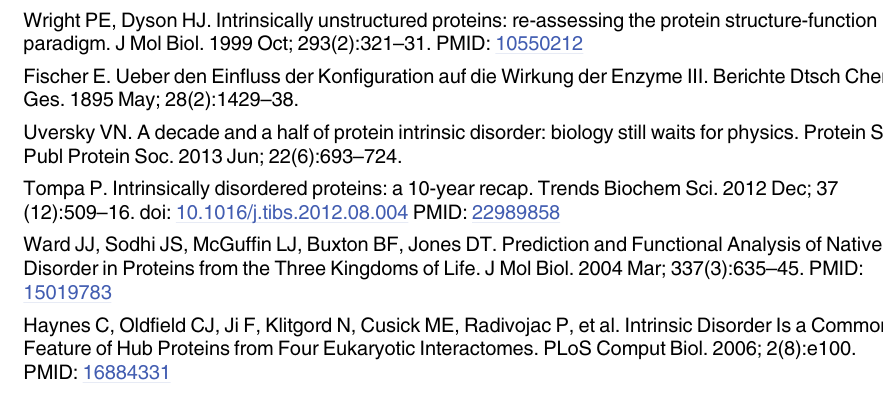
S1 Fig. IDRs are enriched in the cytoplasmic side on transmembrane proteins. Percent of IDRs localized in the cytoplasm or the extracellular domain of single-pass and multi-pass pro- teins according to IUPRED and DISOPRED2 prediction. S2 Fig. Phosphorylation bias in IDPs. (A) Total number of phosphorylated and ubiquitinated residues in both OP and IDP according to Phosphosite. (B) Correlation between protein size and number of phosphorylation sites. (C) Average number of phosphosites as a percent of the total number of amino-acids for each protein. (D) Proportion (in %) of phosphorylated serine, threonine and tyrosine found in IDRs. S3 Fig. Original western-blot of Fig 5. Uncropped version of the western blots used in Fig 5. The black rectangles indicate the area used in the